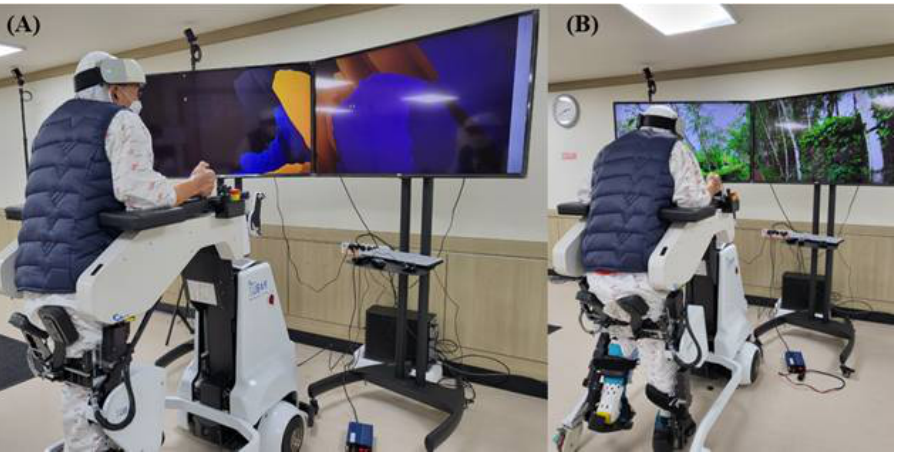
Figure 1. ( A ) Control condition without virtual reality. ( B ) The application of virtual reality to a